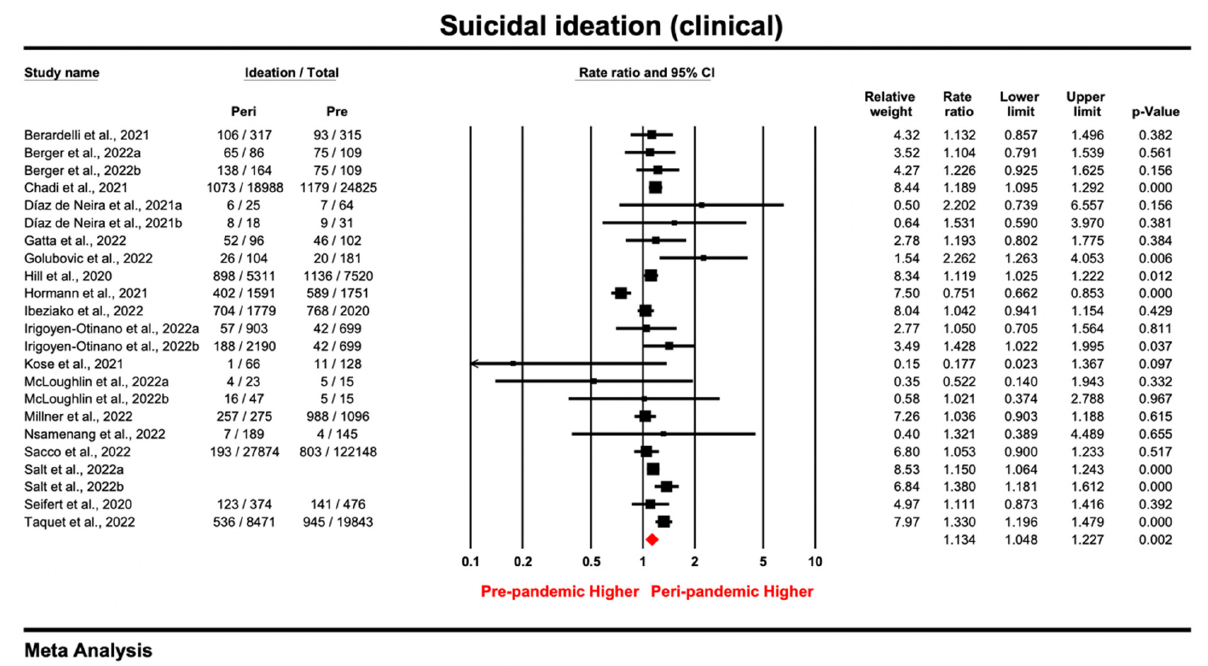
Figure 3. Forest plot for suicidal ideation of studies [16,59,60,62,63,92,94–96,101,103–107,109–111] conducted in the clinical setting (Prismatic colored as red refers to the pooled estimate).